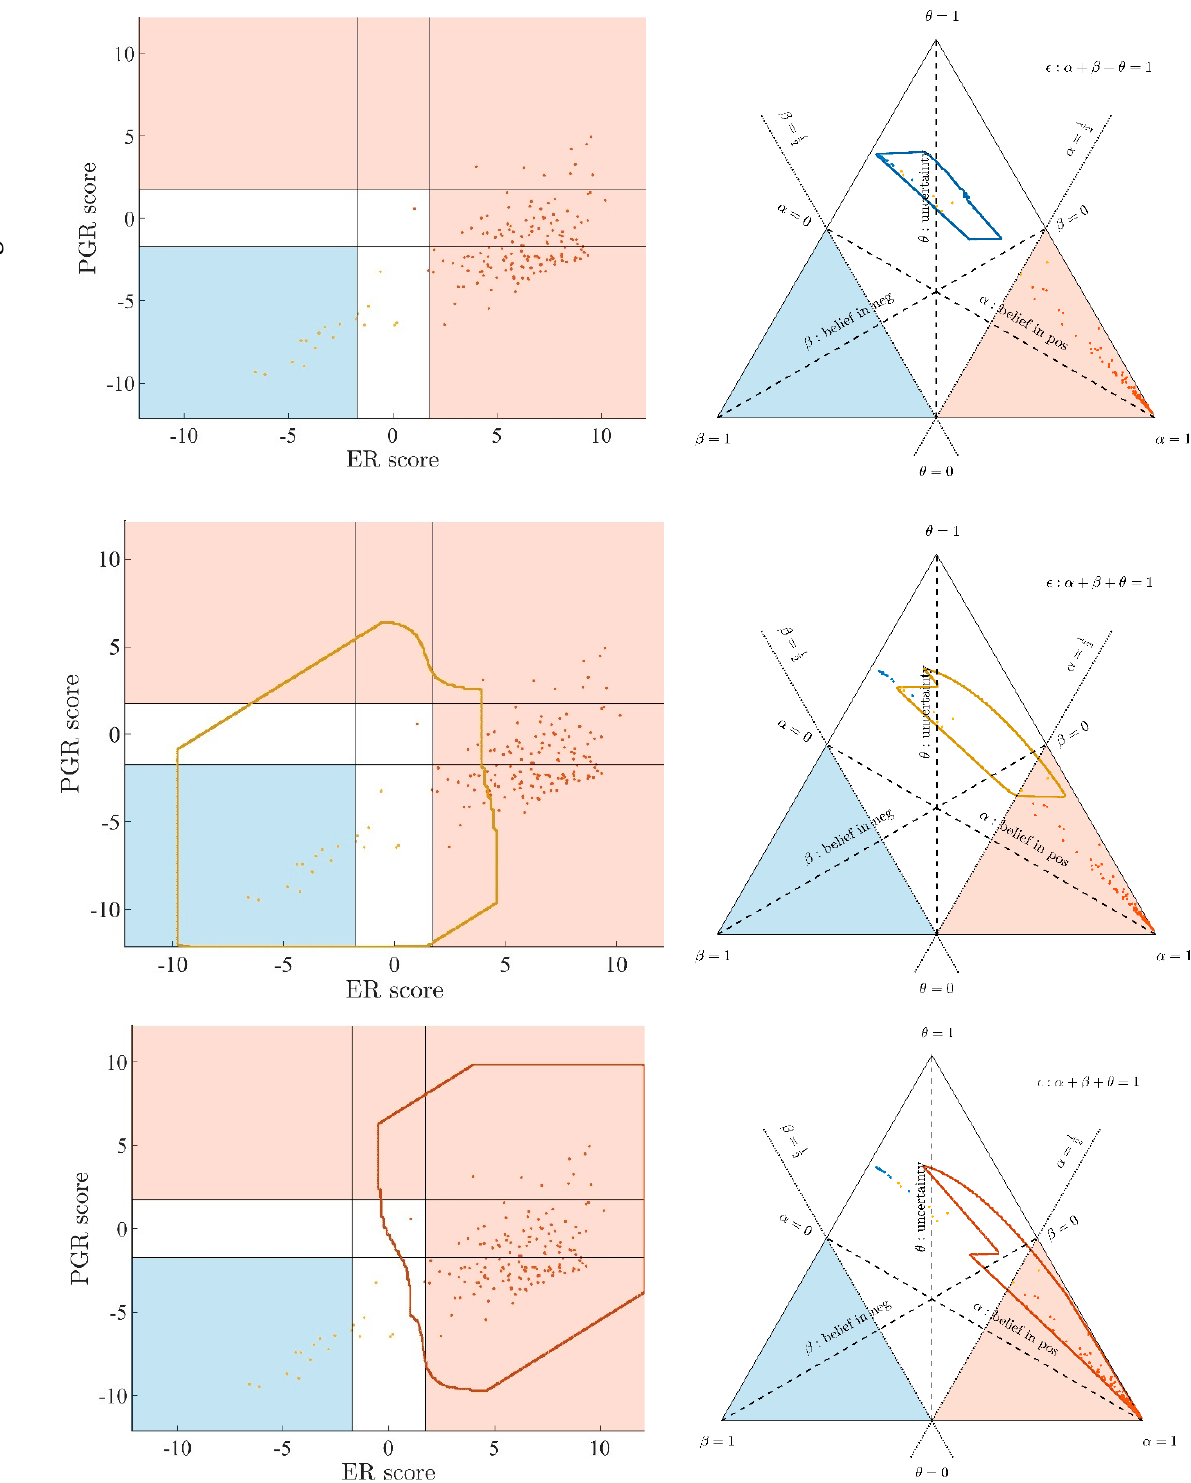
Figure A5. Real sample data within maximum accessible domains for IHC = (+,-). For general features of display see caption to Figure A3.